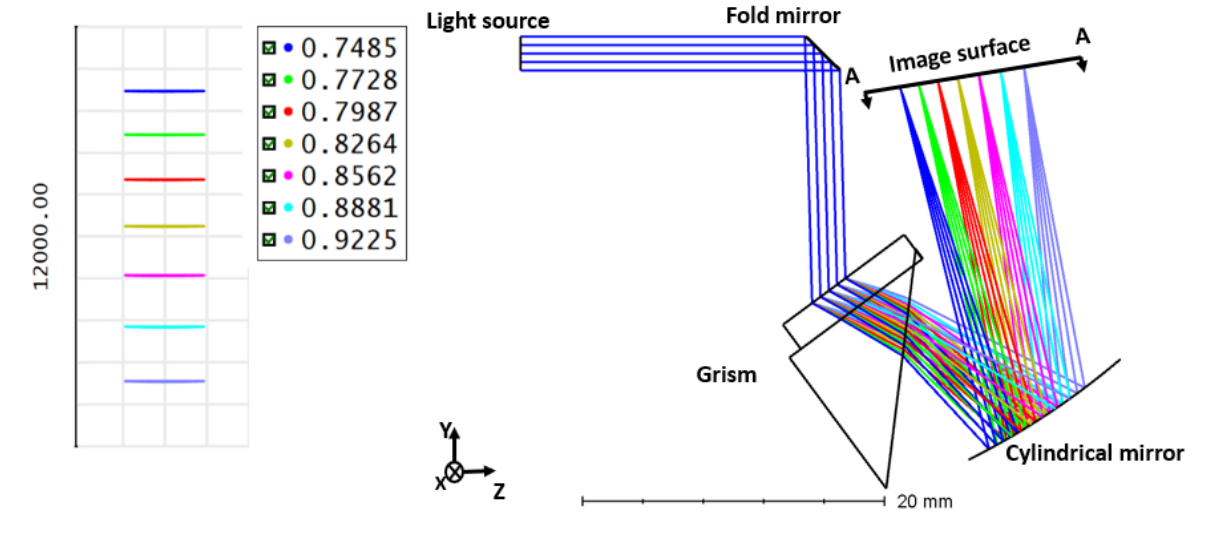
Figure 9. Design of a spectrometer with Grism [30] .